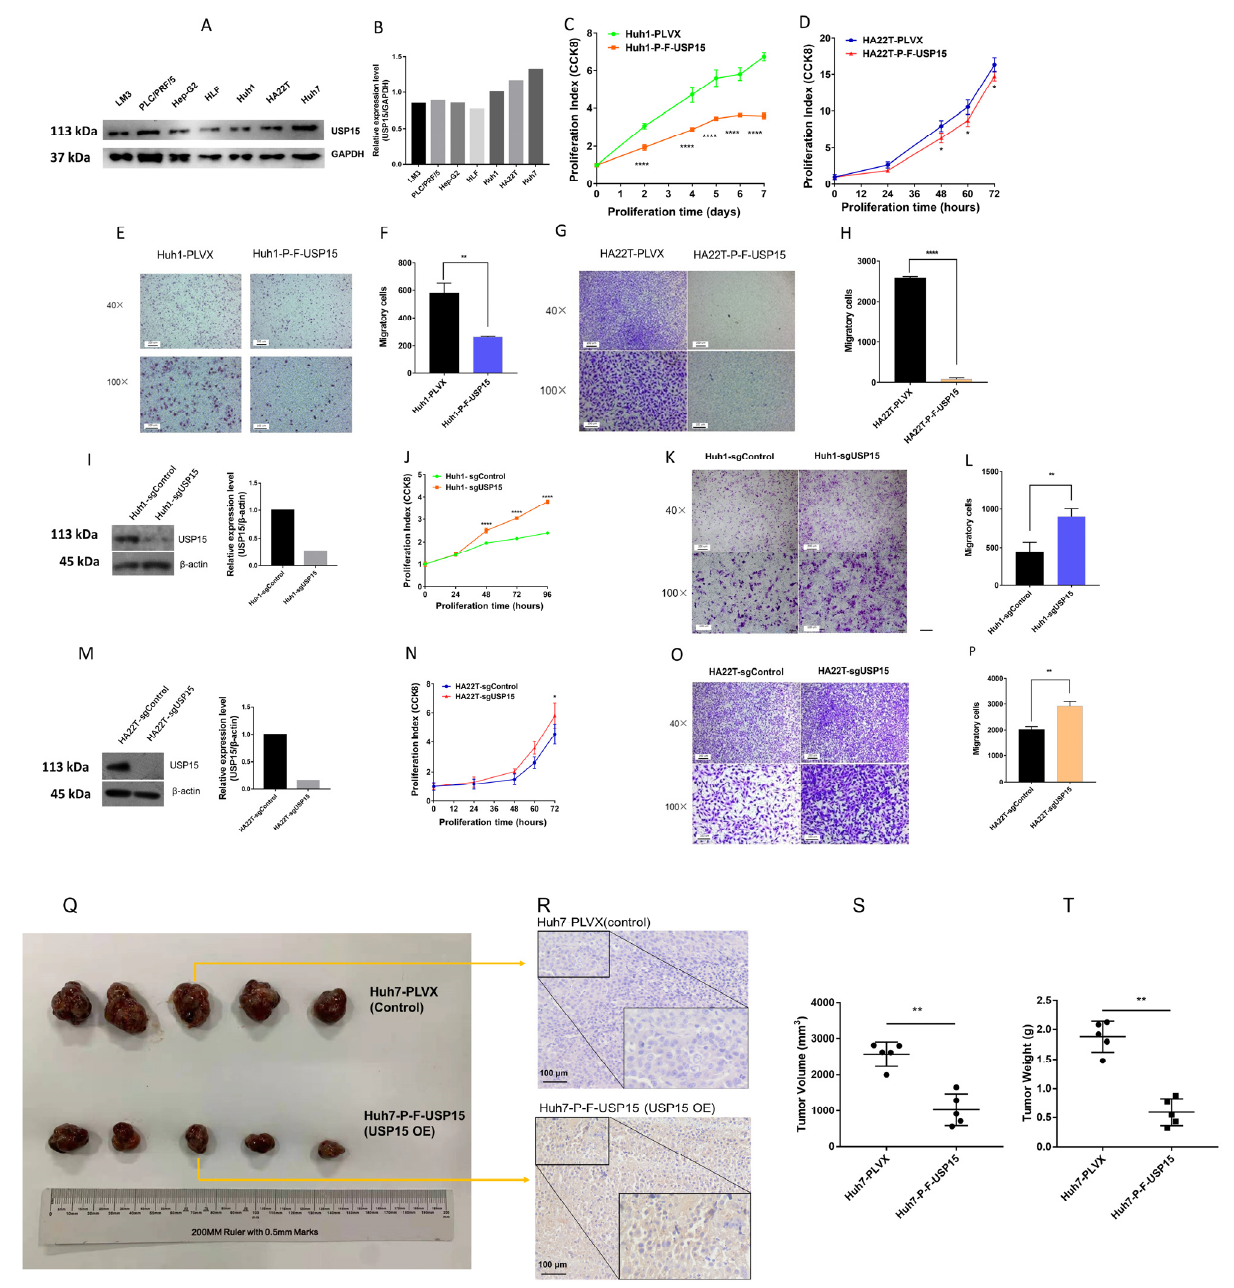
Figure 2. The expression of USP15 is increased in hepatocellular carcinoma cell lines. Overexpression of USP15 correlates with slow proliferation, slow migration, and slow tumor growth. Knockout of USP15 correlates with fast proliferation and fast migration. ( A ) Western blot of USP15 protein expression in cell lines LM3, PLC/PRF/5, HLF, Hep-G2, Huh1, HA22T, and Huh7. Glyceraldehyde 3-phosphate dehydrogenase (GAPGH) is the reference. ( B ) Bar chart of the normalized expression of USP15. We applied GAPGH to normalize the intensity values. HCC cell lines Huh1, HA22T, and Huh7 have the highest expression levels of USP15. ( C ) The proliferation index (CCK8 assay) of transfected cell line Huh1-P-F-USP15 (red line) versus control Huh1-PLVX (green line), see text. Overexpressing cells, Huh1-P-F-USP15, had a decreased proliferation index ( p values at 5 time points all less than 0.0001, two-tailed t -test). ( D ) The proliferation index (CCK8 assay) of transfected cells line HA22T-P-F-USP15 (red line) versus control HA22T-PLVX (green line), see text. Overexpressing cells, HA22T-P-F-USP15, had a decreased proliferation index ( p values at 48 h, 60 h and 72 h are less than 0.05, two-tailed t -test). ( E ) Images of migration assays (Transwell) for cell lines Huh1-PLVX (left images) and Huh1-P-F-USP15 (right images). Images are shown in two magnifications,